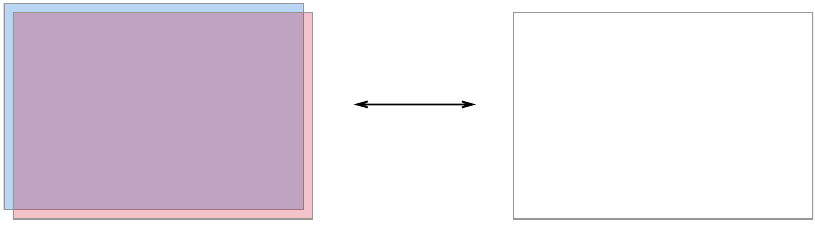
Figure 1 . A system (red) de(cid:12)nes an invertible phase of matter if we can (cid:12)nd another system (blue) such that the combination of the two system is in a trivial